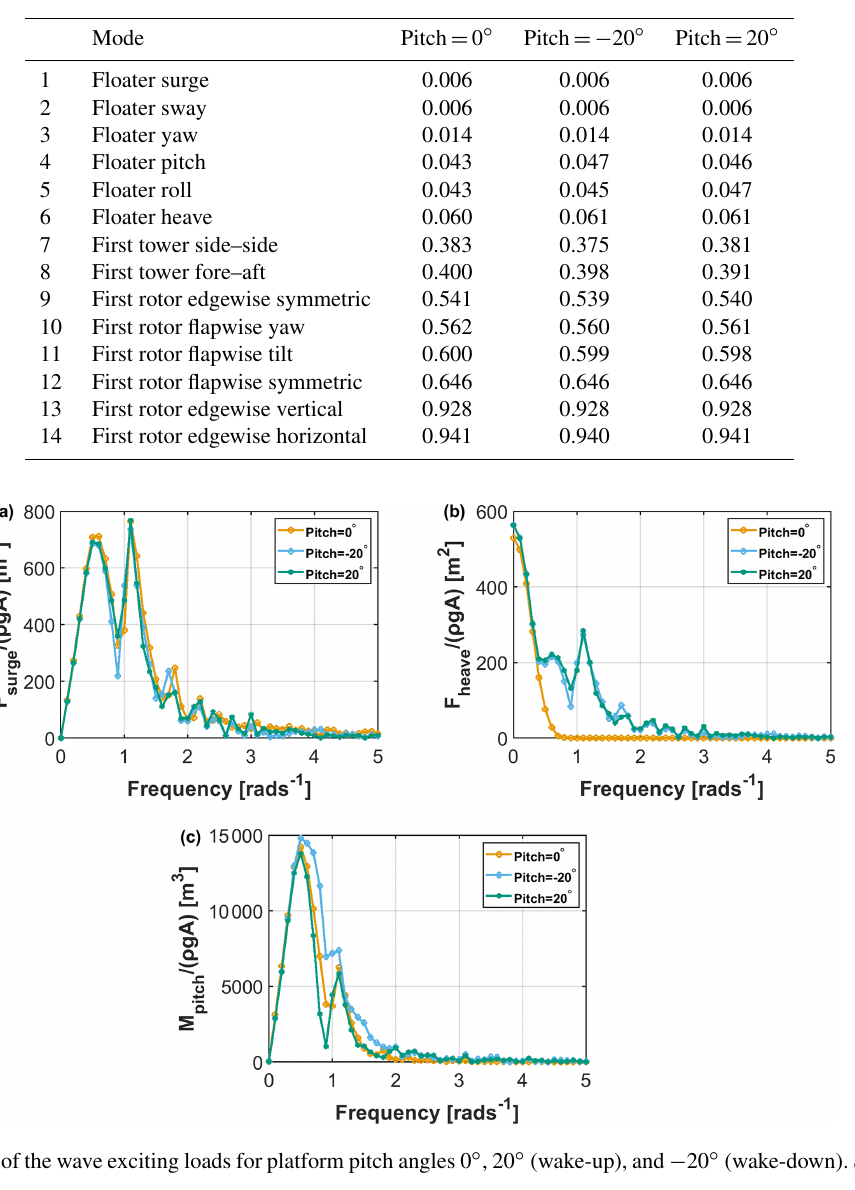
Table 4. Eigenvalues (Hz) of the coupled floating system for three platform pitch angles (0, − 20, and 20 ◦ ).